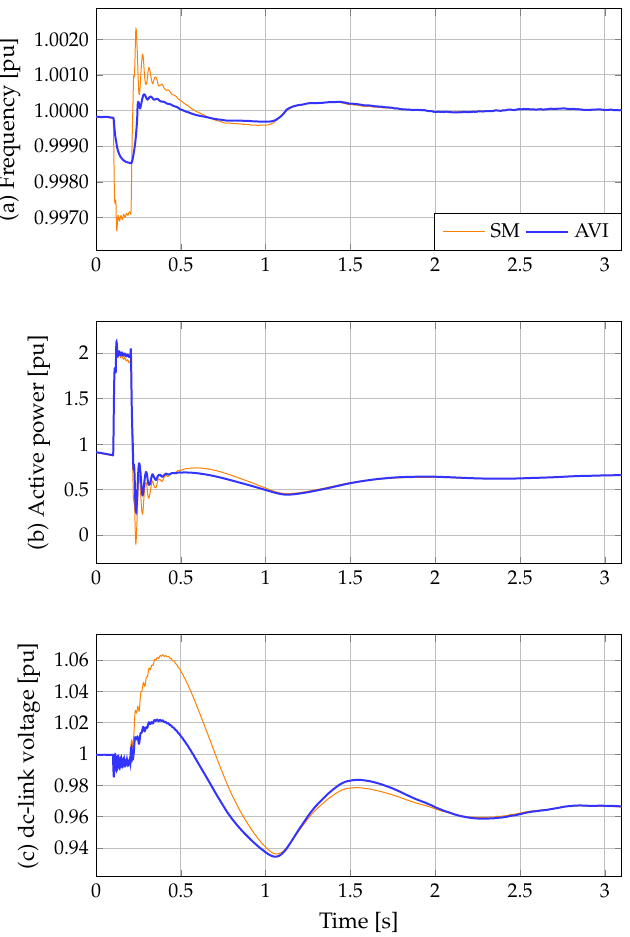
Figure 8. Dynamic responses for case 2: ( a ) frequency, ( b ) active power, and ( c ) dc-link